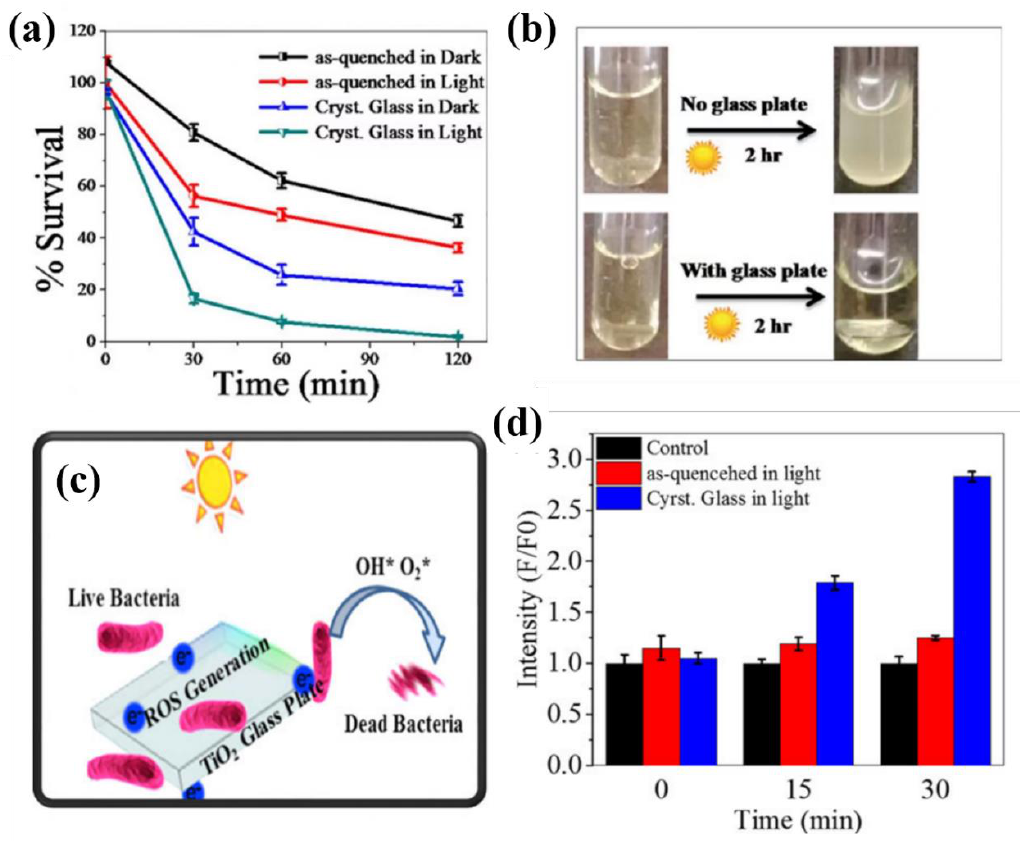
Figure 20. ( a ) % survival of E. coli in dark and under light irradiation from dilution plate method. ( b ) Typical image of E. coli suspension of bacteria in test tubes with and without crystallized glass under 2 h sunlight exposure and then after 24 h incubation. ( c ) Schematic of proposed antibacterial mechanism under solar irradiation. ( d ) Intracellular ROS measurement of bacterial cells in control, as-quenched and crystallized experimental group by relative DCFH fluorescence intensity. Reprinted with permission from Ref.